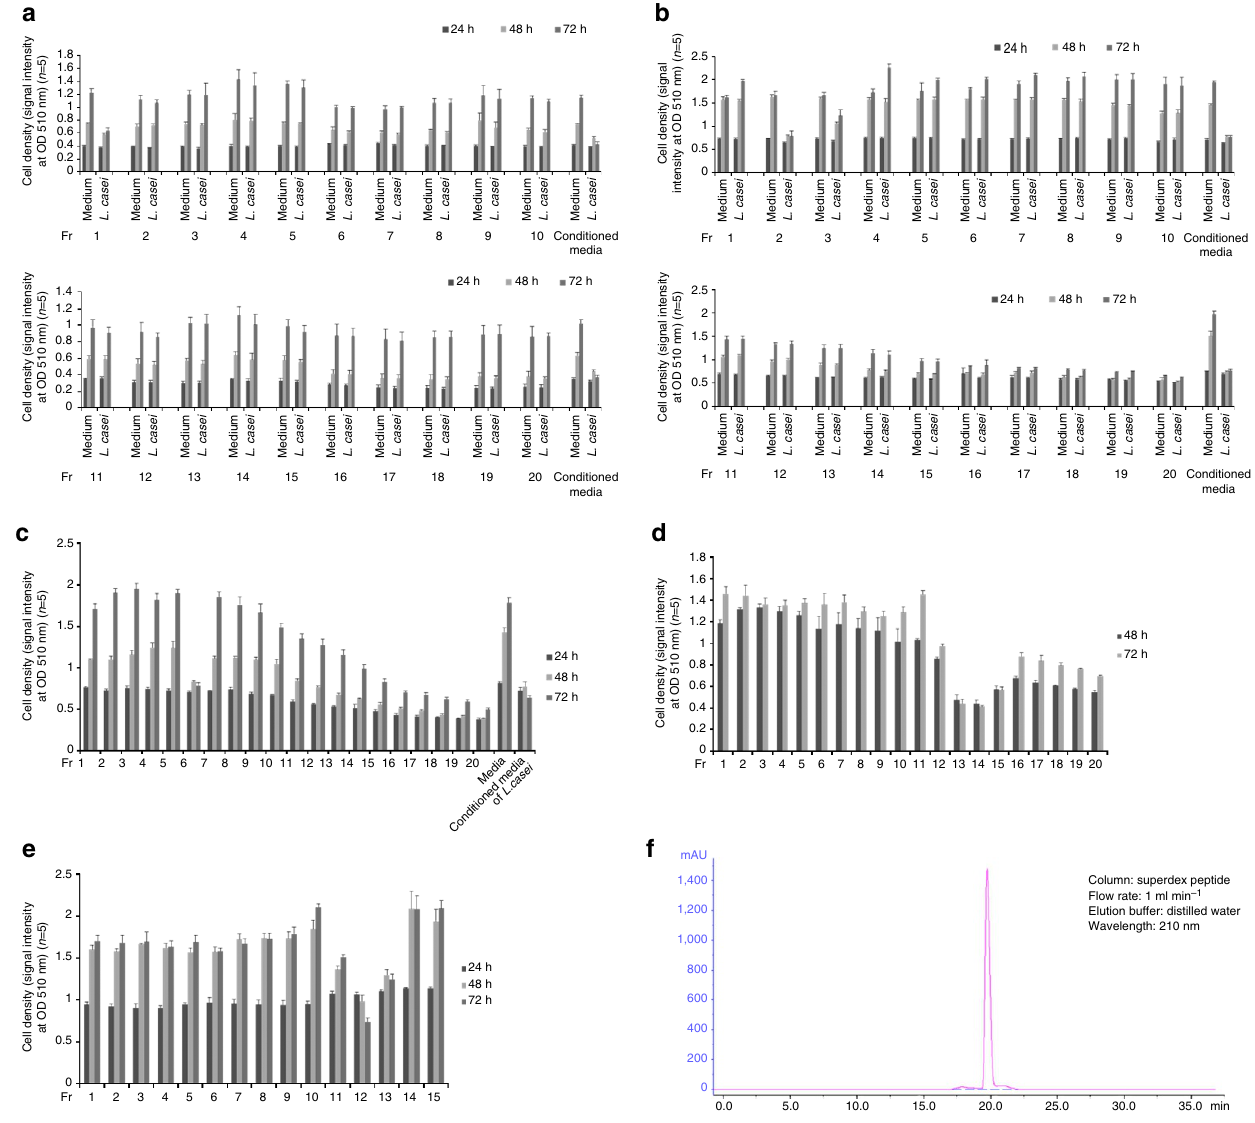
Figure 3 | The separation of the tumour-suppressive fraction from the L. casei ATCC334 culture supernatant. ( a ) The fractions were assessed using DEAE anion-exchange chromatography and a tumour-suppressive effect was identified in the 1st fraction by reverse-phase chromatography ( b ). The fractions were assessed by CM cation-exchange chromatography and a tumour-suppressive effect was identified in the 2nd fraction by DEAE anion-exchange chromatography ( c ). The fractions were assessed by SPcation-exchange chromatography and a tumour-suppressive effect was identified from the 6th fraction by CM cation-exchange chromatography ( d ). The fractions were assessed by ZIC-HILIC chromatography and a tumour-suppressive effect was identified in the 13th fraction by SP cation-exchange chromatography ( e ). An HPLC chromatogram of the tumour-suppressive fraction. The sample was separated on a Superdex peptide column, eluted with distilled water at a flow rate of 1mlmin (cid:2) 1 . The eluent was monitored by ultraviolet spectrophotometry at 210nm ( f ). The error bars show the s.d. ( n ¼ 5).